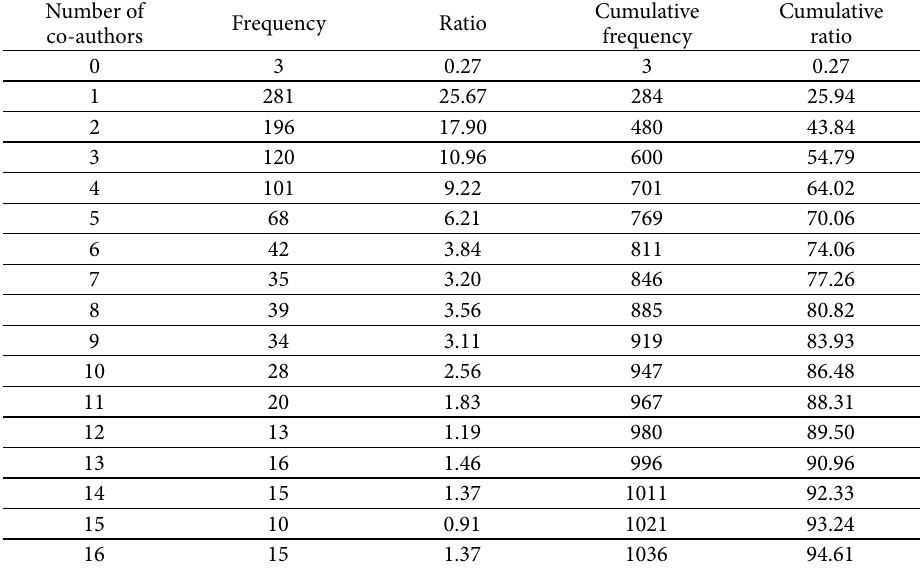
Table 3. Distribution of the number of co-authors per researcher in the NBI network Number of